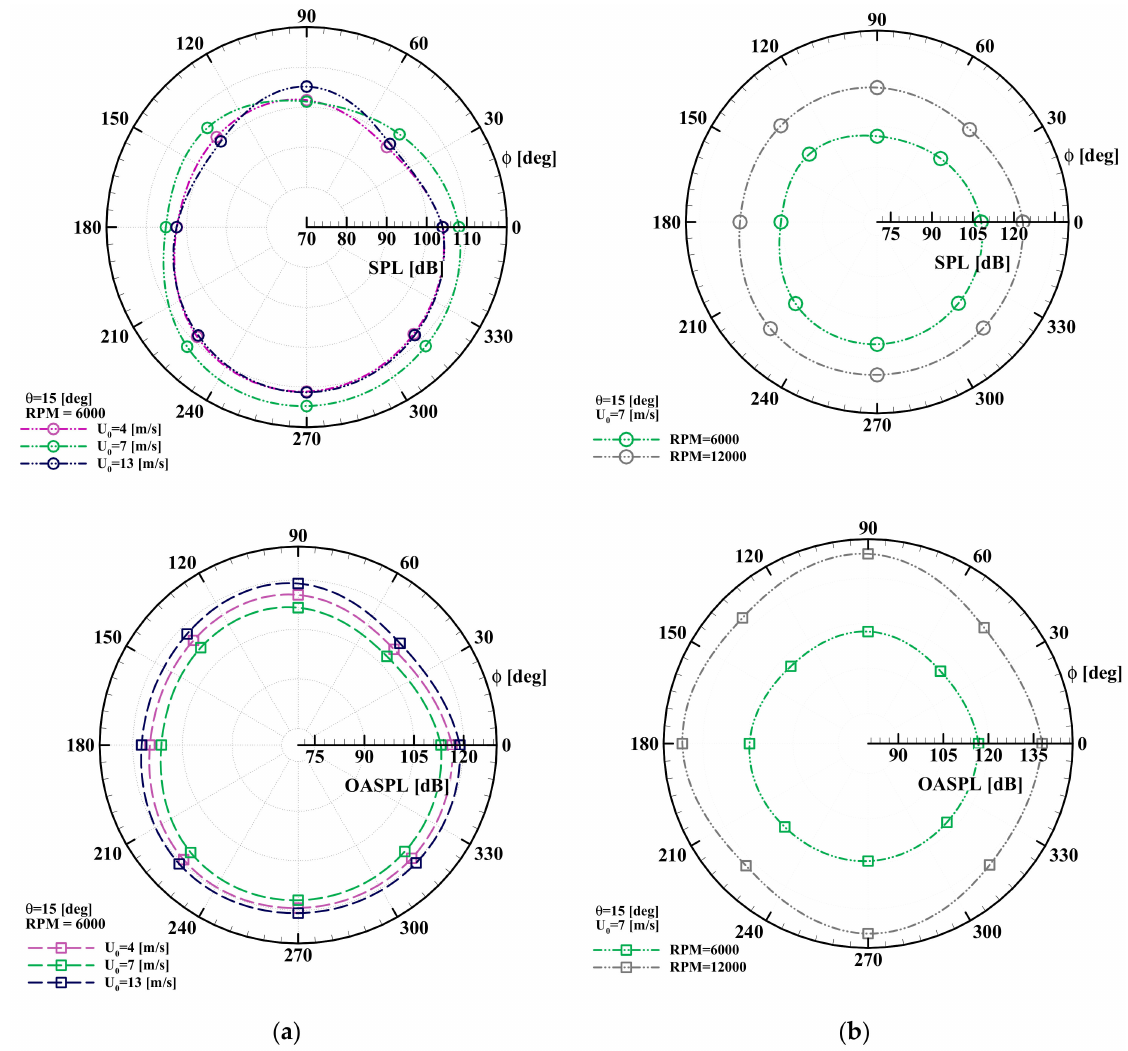
Figure 10. Directivity of SPL ( top ) and OASPL ( bottom ) around CRC-3: ( a ) varying velocity; ( b ) varying